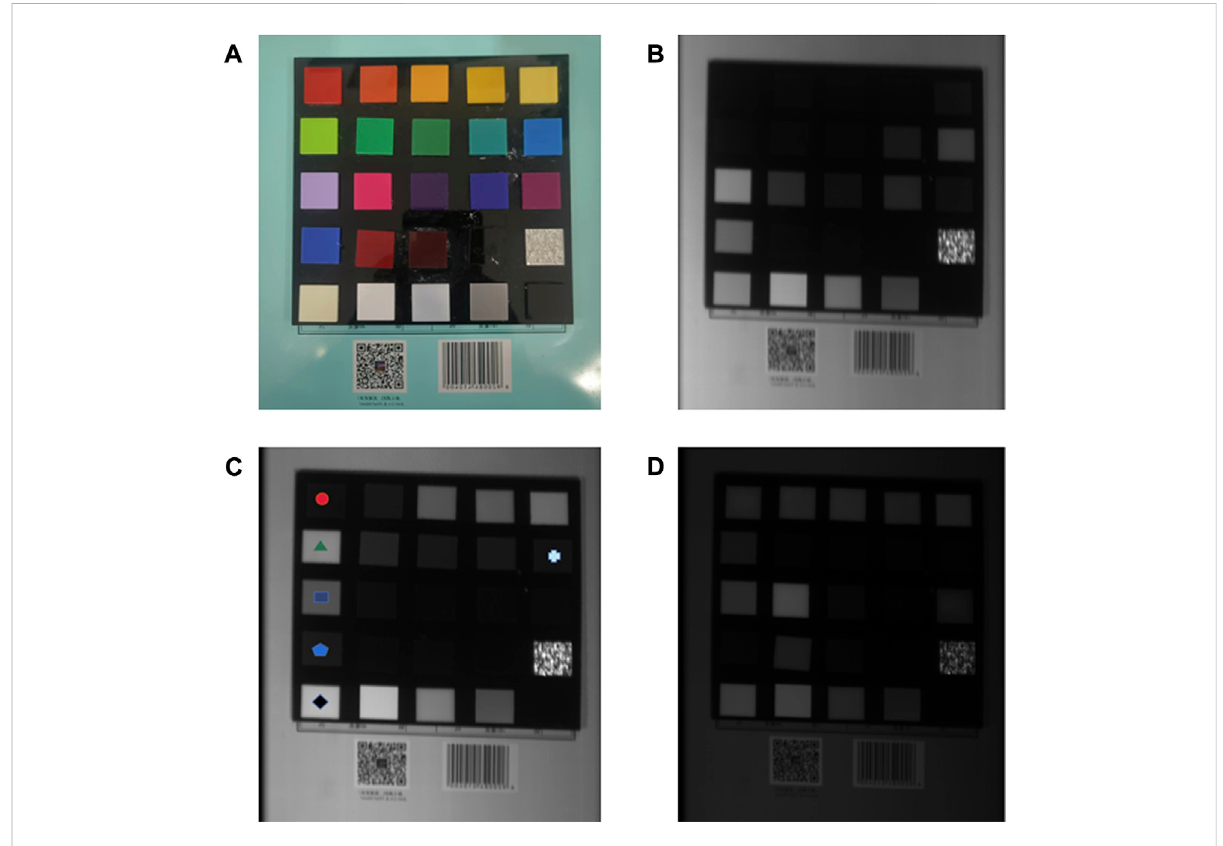
FIGURE 10 Monochromatic image obtained by the system. (A) Actual color blocks. (B) Monochromatic image of the color blocks at 455 nm. (C) Monochromatic image of the color blocks at 555 nm. (D) Monochromatic image of the color blocks at 655